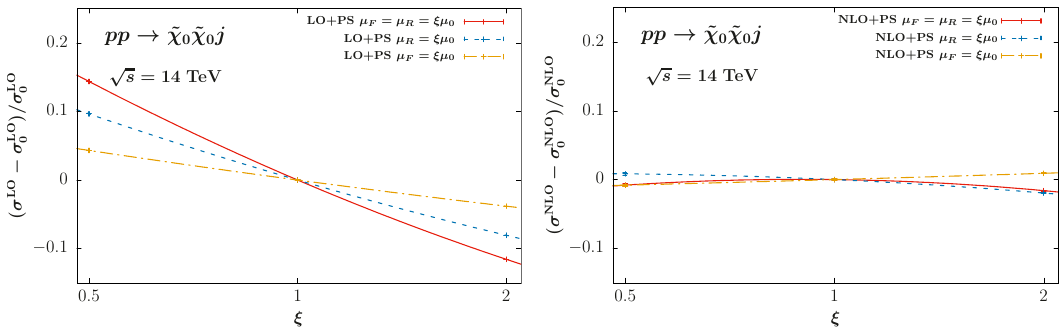
~ (cid:31) 0 ~ (cid:31) 0 j with p s = 14 TeV 1 1 !